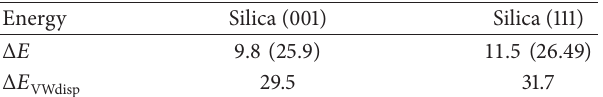
Table 2: Binding energy ( Δ𝐸 ) (kcal/mol) of L-dopa adsorbed on silica